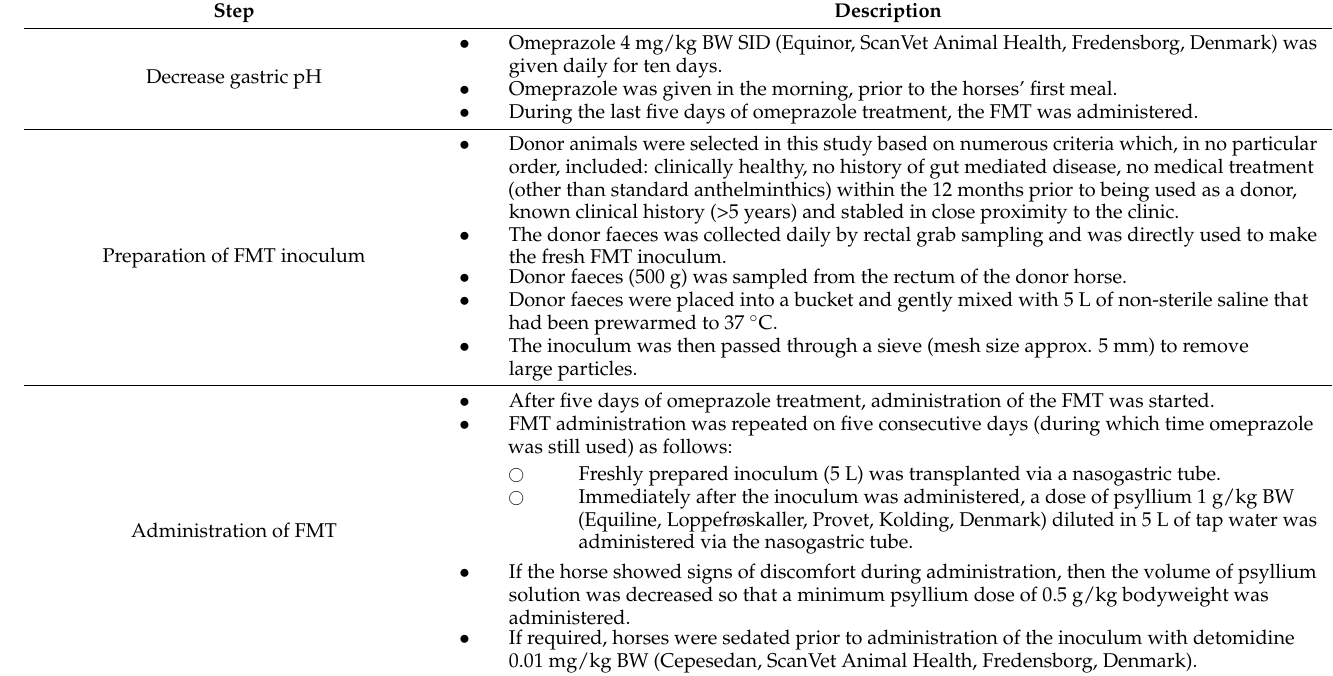
Figure 1. Clinical field study overview. Ten free faecal water (FFW) horses were treated with a standardized faecal microbiota transplant (FMT) protocol for 10 days (d –9 to d 0). Donor transplants were administered on five consecutive days (d –4 to d 0) of the standardized FMT protocol. After d 0, FFW horses received no further treatment. FFW horses were then visited multiple times over a 24-week period (i.e., d 7 to d 168) for post FMT assessment and faecal sampling. Faecal samples were collected before (d –9) and after (d 0, 7, 14, 28, 84 & 168) the treatment was completed. At 48 weeks (i.e., d 336) post FMT, a telephone questionnaire was performed as a final follow-up. Table 1. Standardised faecal microbiota transplantation (FMT) protocol used in this